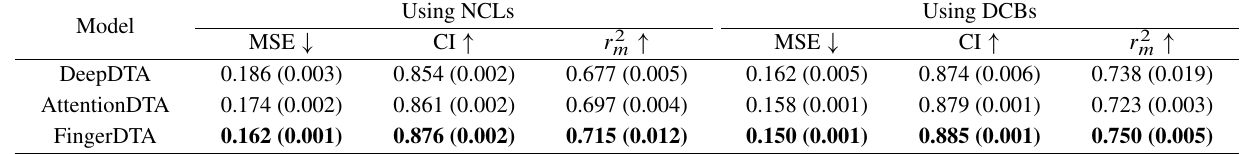
Table 5 Ablation results on the testing data of the KIBA data